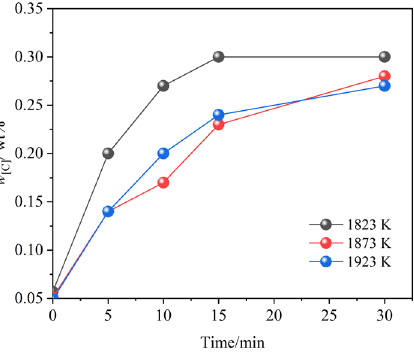
Figure 7. Variation of the C content in molten steel at different smelting temperatures at slag = 5 wt%, initial Sb = 0.06 wt%, initial C content = 0.05 wt%, and initial CaC 2 = 20